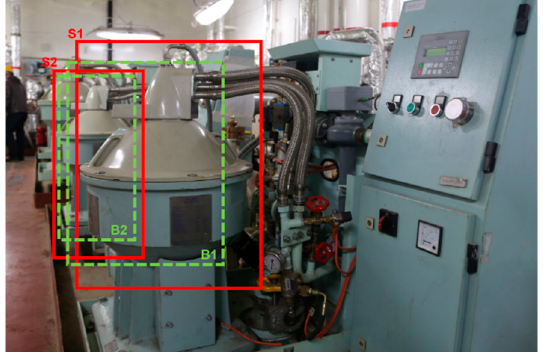
Figure 6. An example of auxiliary equipment detection in a congested marine engine room. B1 and B2 are the prediction boxes for the S1 and S2 target separators. In traditional NMS, B2 may be misguided to S1 or suppressed by B1.